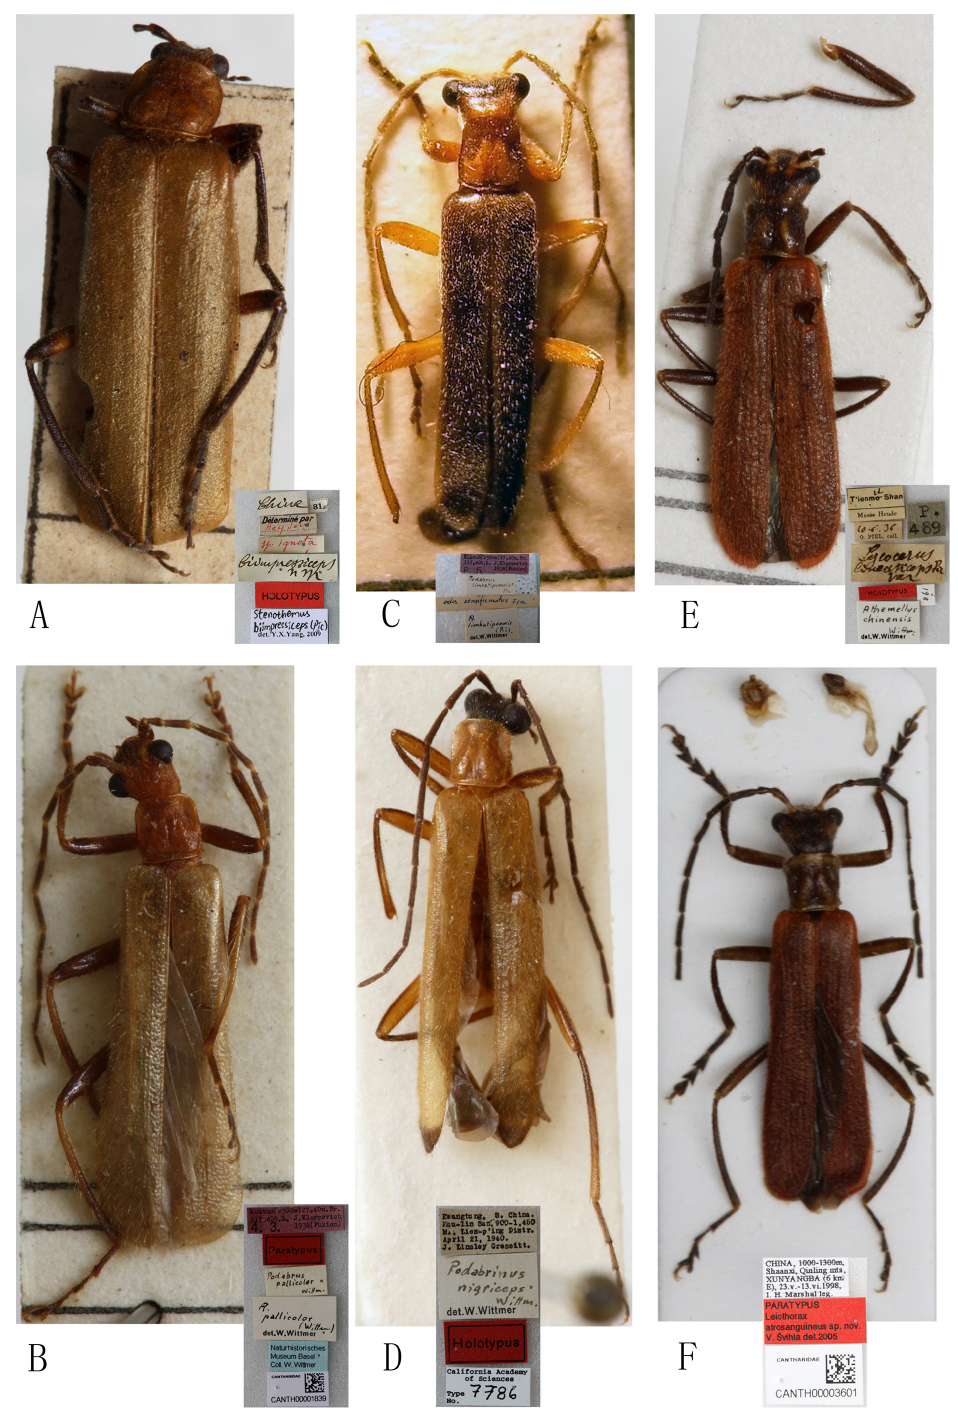
Fig. 1. Habitus, dorsal view. A . Stenothemus biimpressiceps (Pic, 1930) comb. nov., holotype, ♀ (MNHN), originally in Cantharis Linnaeus, 1758. B . S. pallicolor (Wittmer, 1951) comb. nov., paratype, ♂